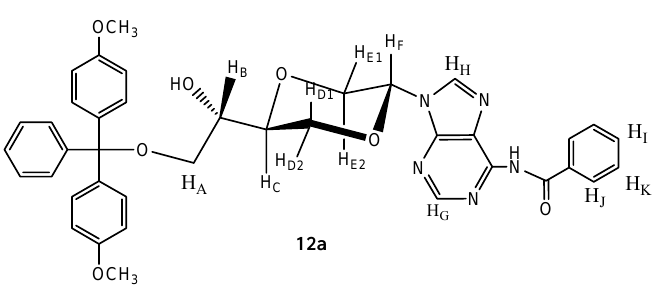
Figure 6. Structure of compound 12a .